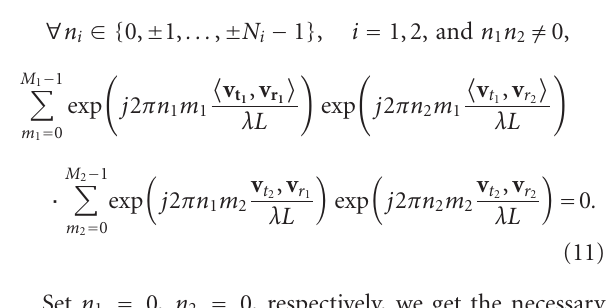
Figure 2: Two-dimensional antenna